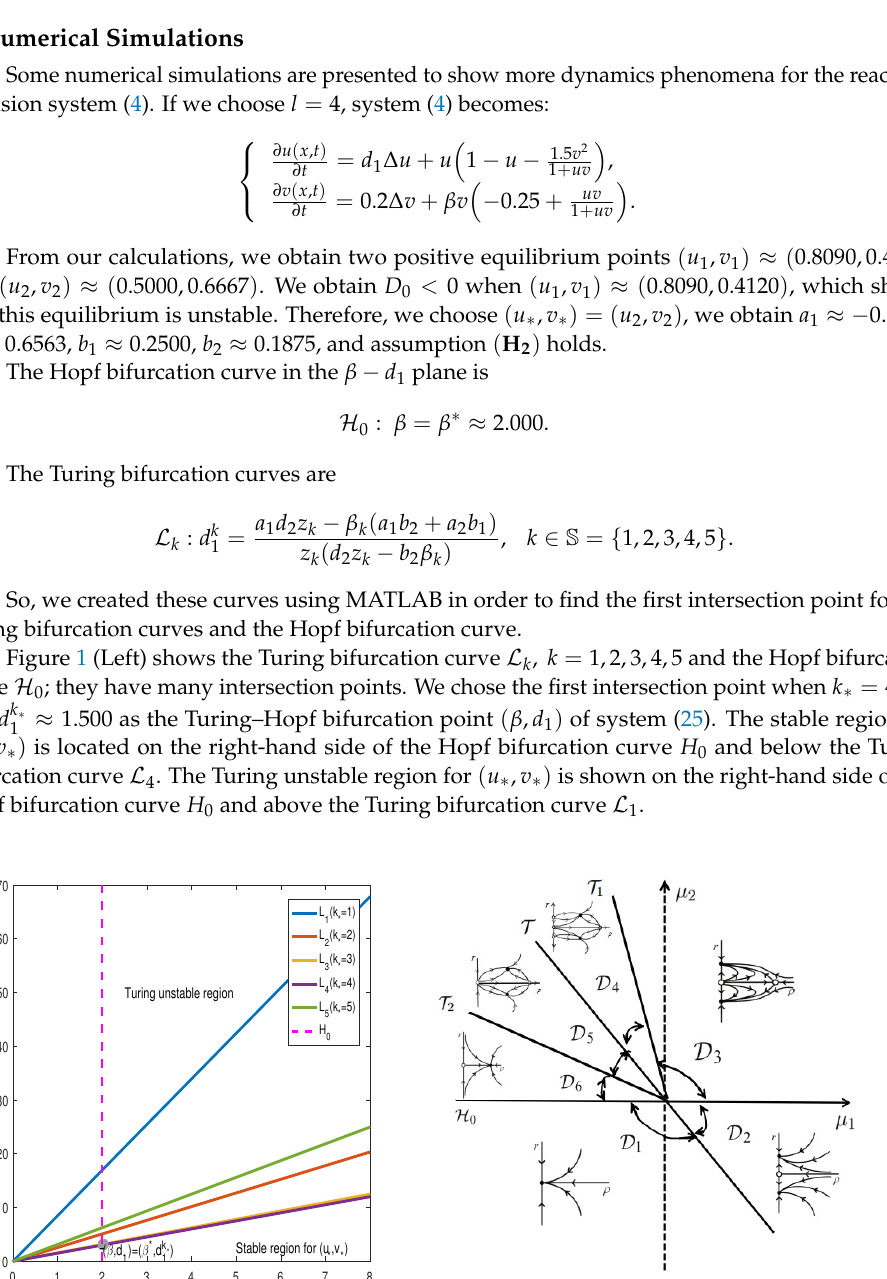
β plane. Right : the phase −